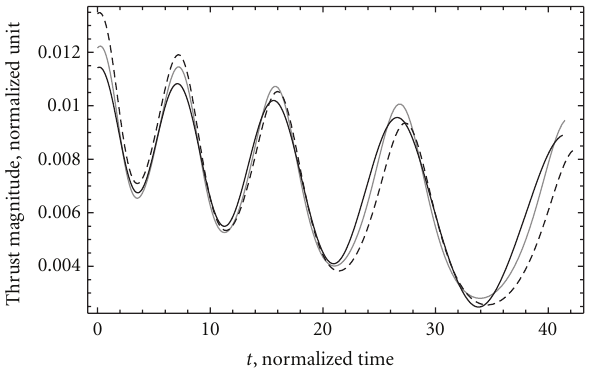
Figure 6: Thrust magnitude comparison of di ff erent trajectories in case D.